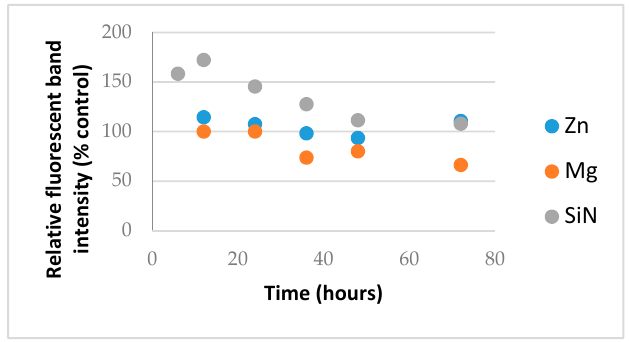
Figure 5. RNA compatibility of ZnO ( blue ) and MgO ( orange ) relative to silica nitride (SiN 4 ) control ( grey ).